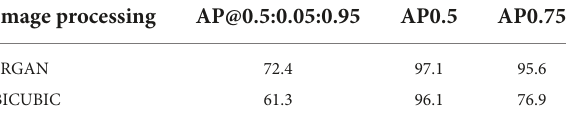
TABLE 1 Average precisions (APs) for different intersection over union (IoU) thresholds based on super-resolution generative adversarial network (SRGAN) and